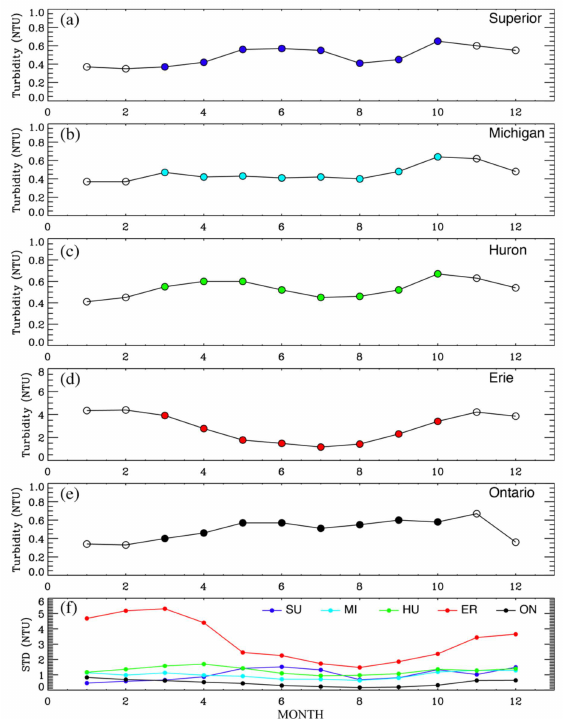
Figure 5. VIIRS–SNPP-derived mean climatology (2012–2018) monthly water turbidity in the Great Lakes for ( a ) Lake Superior, ( b ) Lake Michigan, ( c ) Lake Huron, ( d ) Lake Erie, and ( e ) Lake Ontario. Plot ( f ) shows standard deviation (STD) values from climatology monthly water turbidity data for the five corresponding lakes. Filled circles in ( a )–( e ) highlight non-winter months, and SU, MI, HU, ER, and ON in ( f ) stand for lakes Superior, Michigan, Huron, Erie, and Ontario,